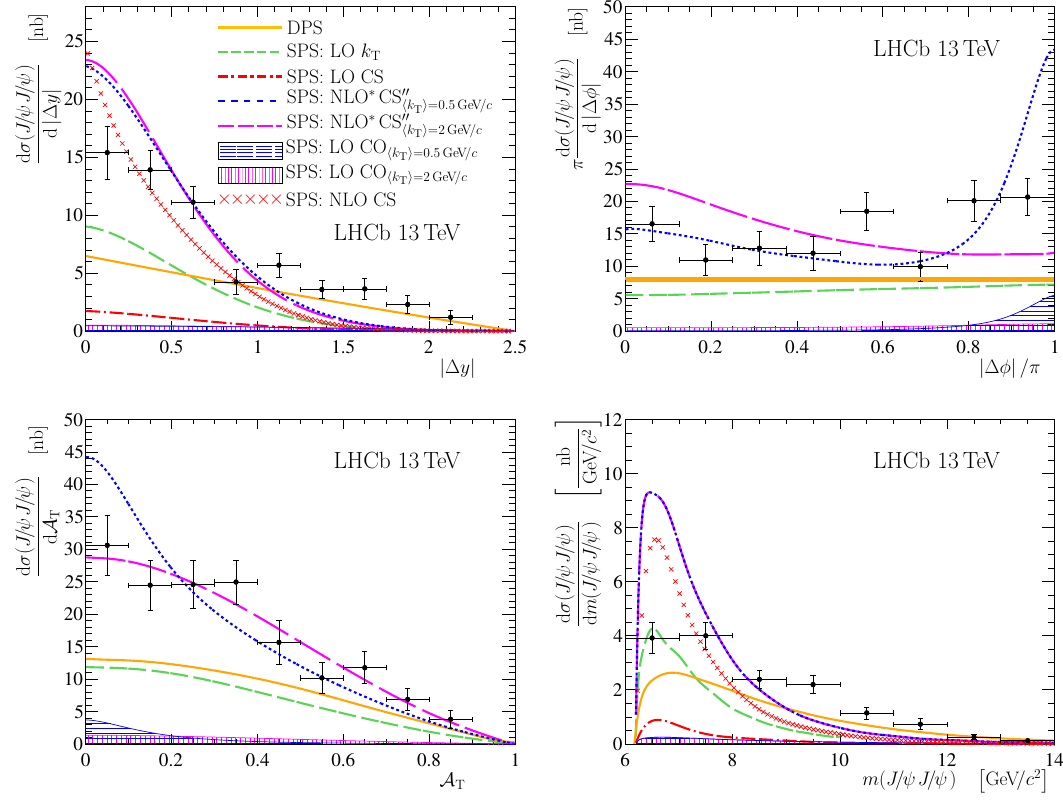
Figure 4. Comparisons between measurements and theoretical predictions for the di(cid:11)erential cross-sections as functions of (top left) right) m ( J= J= ). The (black) points with error bars represent the